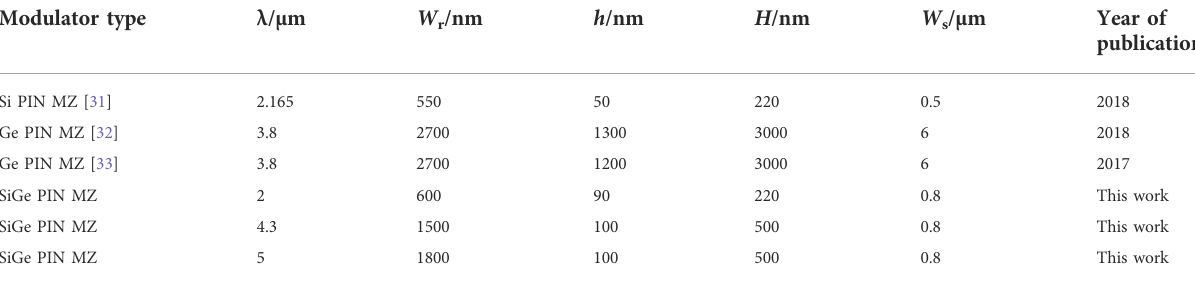
TABLE 1 Comparison of different modulator